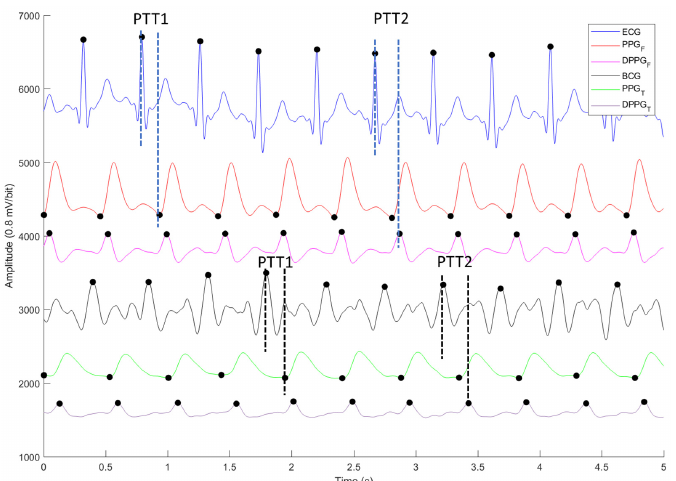
Figure 4. The four signals and their differential signals, ECG (blue), PPGF (red), PPGT (green), BCG (black), differential PPGF (DPPGF, pink) and PPGT (DPPGT, purple). The R wave of ECG, J wave of BCG, main peak of differential PPG, and foot point of PPG are marked by black dots.